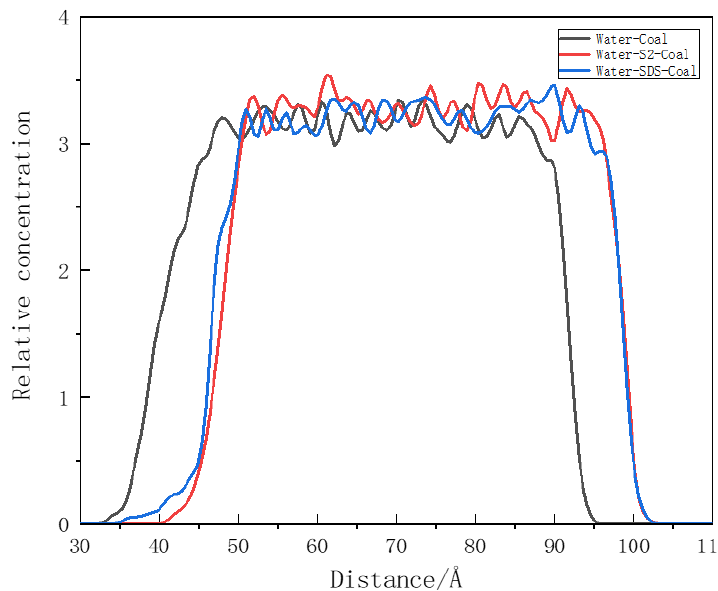
Figure 9. Relative concentration distribution of water molecules along the Z axis.